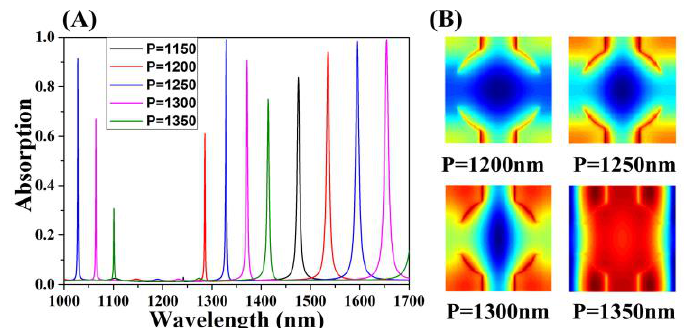
Figure 6. Changes in absorption while varying the period P of the absorber structure and keeping the other parameters unchanged. ( A ) When P increased from 1150 nm to 1350 nm, the corresponding optical absorption was obtained. ( B ) When the structure had a different period P , the electric field map corresponding to the graphene layer was obtained.